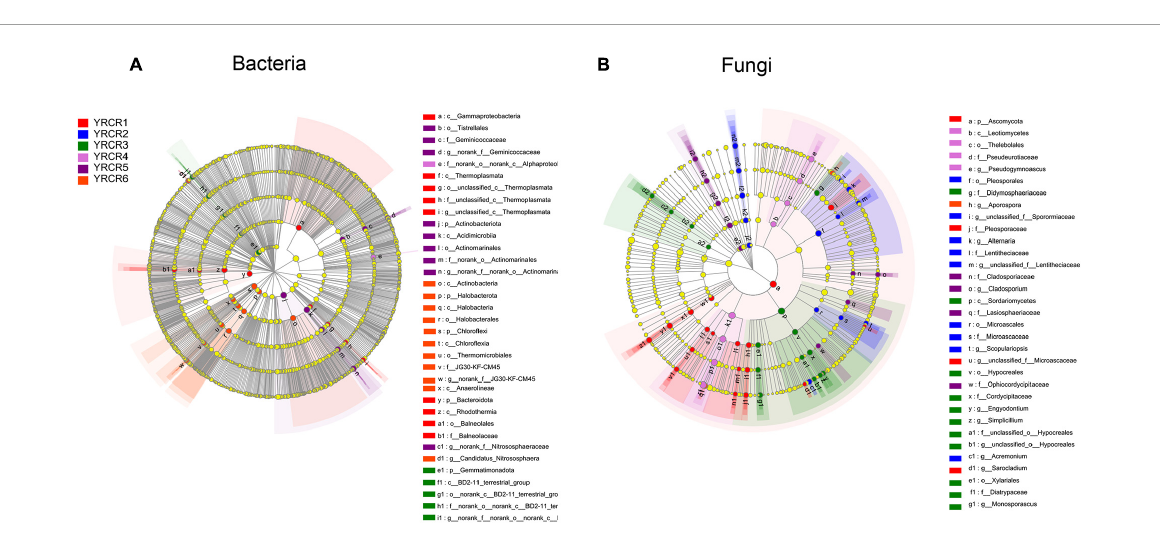
FIGURE4 LEfSe analysis showing the different biomarkers among different ginseng cultivars rhizosphere in bacteria (A) and fungi (B) . Different colored regions represented different constituents, the diameter of each circle is proportional to the relative abundance of the taxon. The inner to outer circle corresponds to the level of the phylum to the